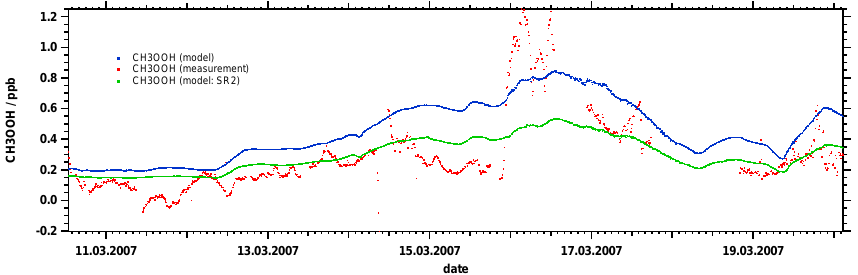
Figure 5. Time series of observed (red) and simulated (blue) methylhydroperoxide mixing ratios. The green line shows a sensitivity simula- tion (SR2) including the reaction of CH 3 O 2 with OH (see text for